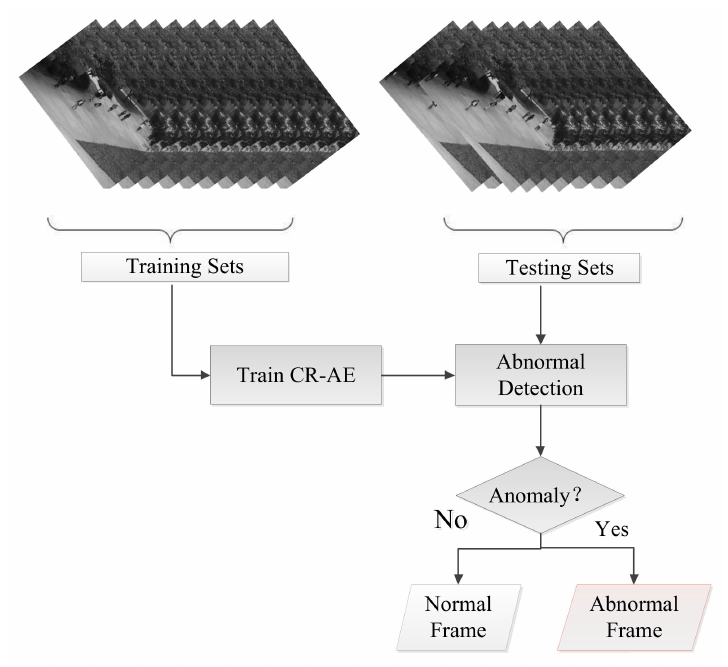
Figure 3. Overview of our proposed method.